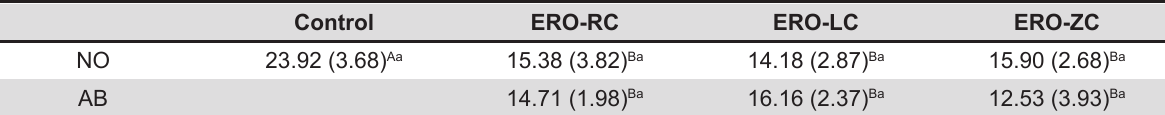
Erosive cola-based drinks affect the bonding to enamel surface: an in vitro Table 1- Means and standard deviations (MPa) of eroded/abraded enamel specimens restored with resin composite